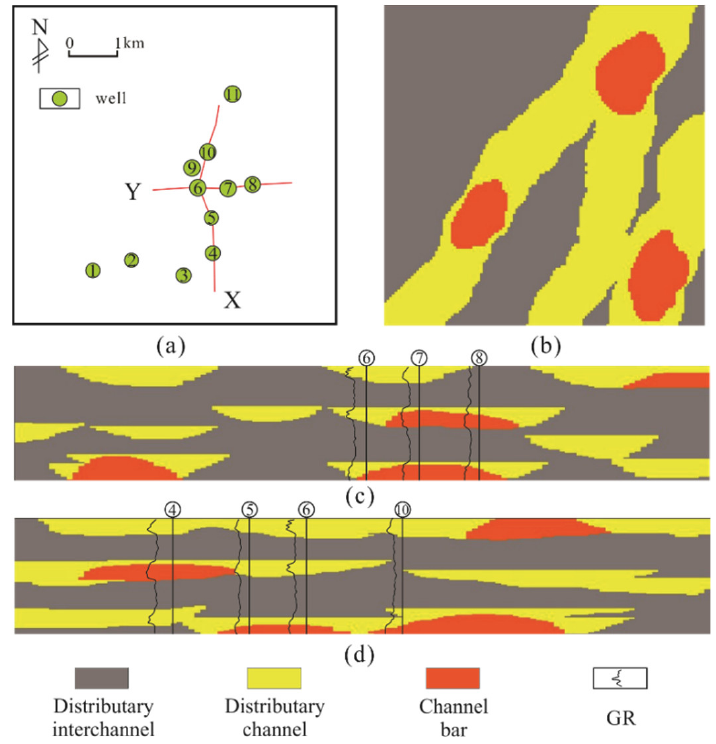
Figure 7. Digital 2D TIs. ( a ) Selection of the direction of TIs on the profile; ( b ) planar 2D TI—Z; ( c ) 2D TI along the source direction—X; ( d ) 2D TI perpendicular to the source direction—Y.